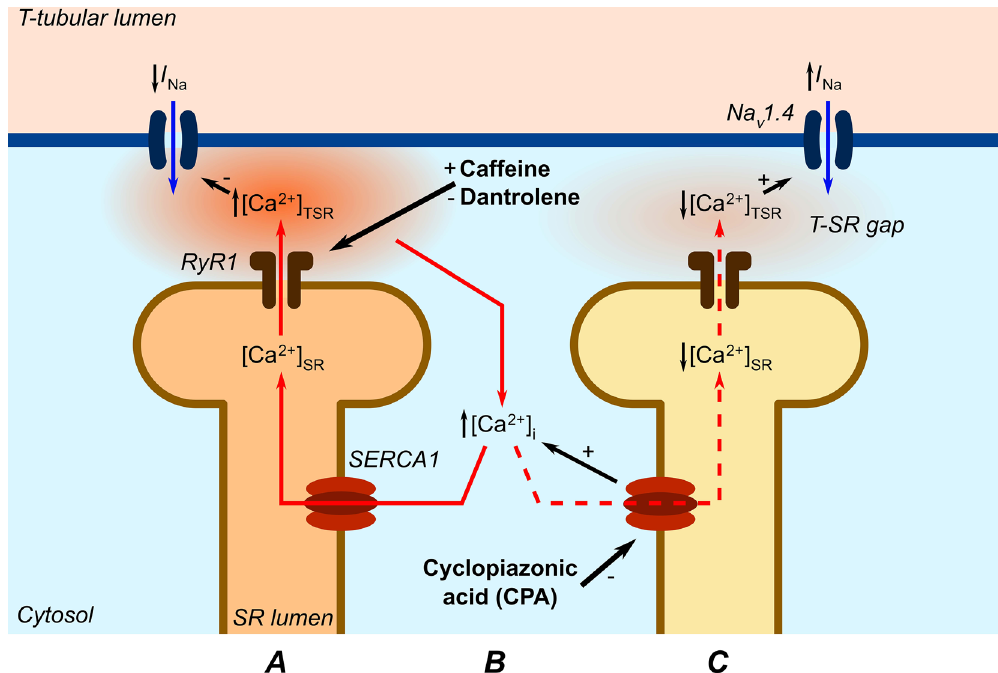
Figure 7. T-SR Ca 2+ microdomain effects reconcile present with previous results. ( A ) In previous experiments 9,10 , caffeine and 8-CPT-induced RyR1-Ca 2+ release channel opening increased fluxes of SR store Ca 2+ into the T-SR space increasing its Ca 2+ concentration, [Ca 2+ ] TSR13 , and ultimately ( B ) that of remaining cytosol, [Ca 2+ ] i . This inhibits I Na . Such actions were antagonized by dantrolene. [Ca 2+ ] i is here also increased by ( B ) inhibiting cytosolic Ca 2+ re-uptake by the SERCA inhibitor CPA 14 , but ( C ) the consequent depletion of SR Ca 2+ , reduces SR store Ca 2+ fluxes into the T-SR space. The latter correspondingly reduces [Ca 2+ ] TSR relieving its background inhibition of, thereby increasing , I Na